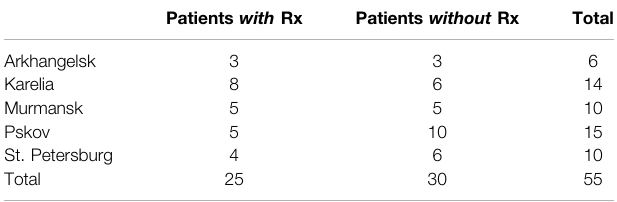
TABLE 1 | Interviews conducted per region. TABLE 2 | Overview of patients with